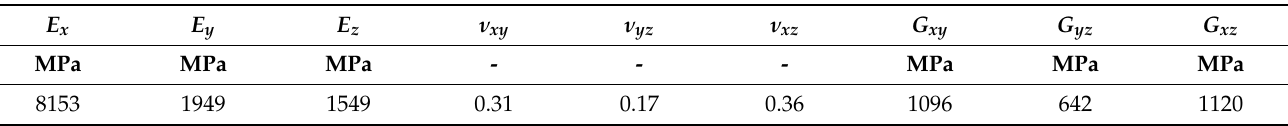
Table 5. The model has been successfully validated for longitudinal strains of up to 1.8% and can be used for simulation. Table 5. Overview of the identified material parameters for 15 wt.% short carbon-fibre reinforced PETG filament (Formfuture